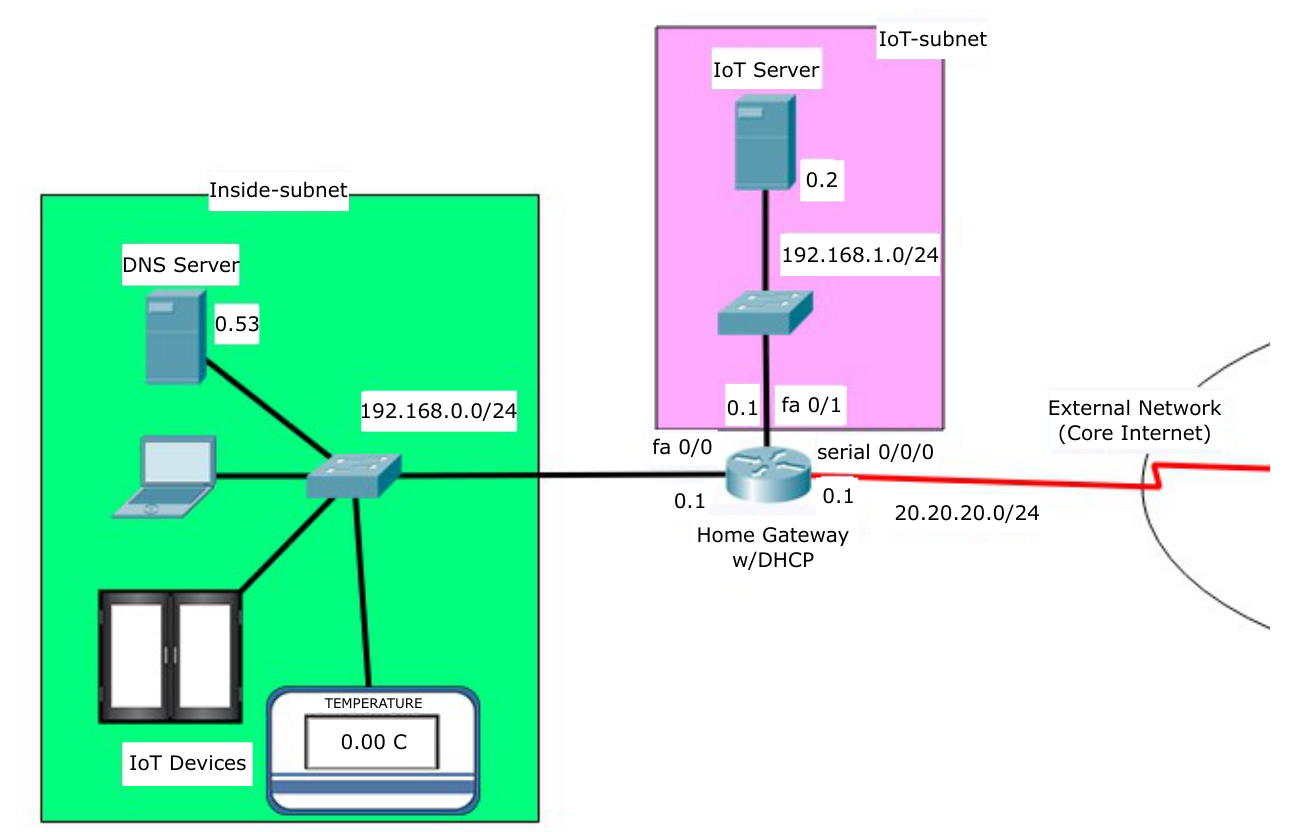
Figure 1. Design of the home network for IoT service.